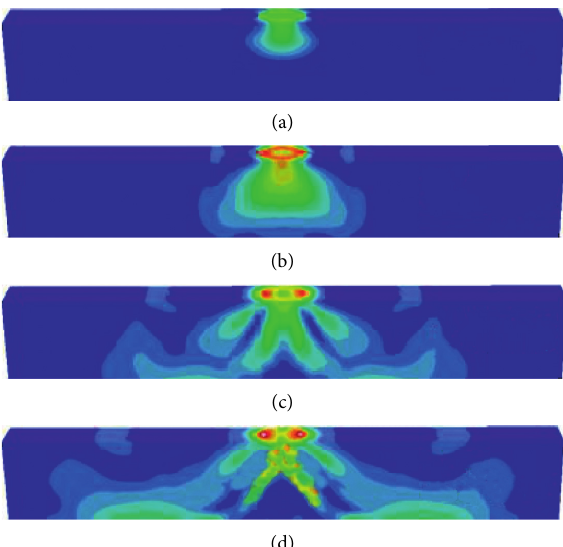
Figure 15: Development of the local damages: (a) 1ms, (b) 1.2ms, (c) 1.4ms, (d) 1.7ms.